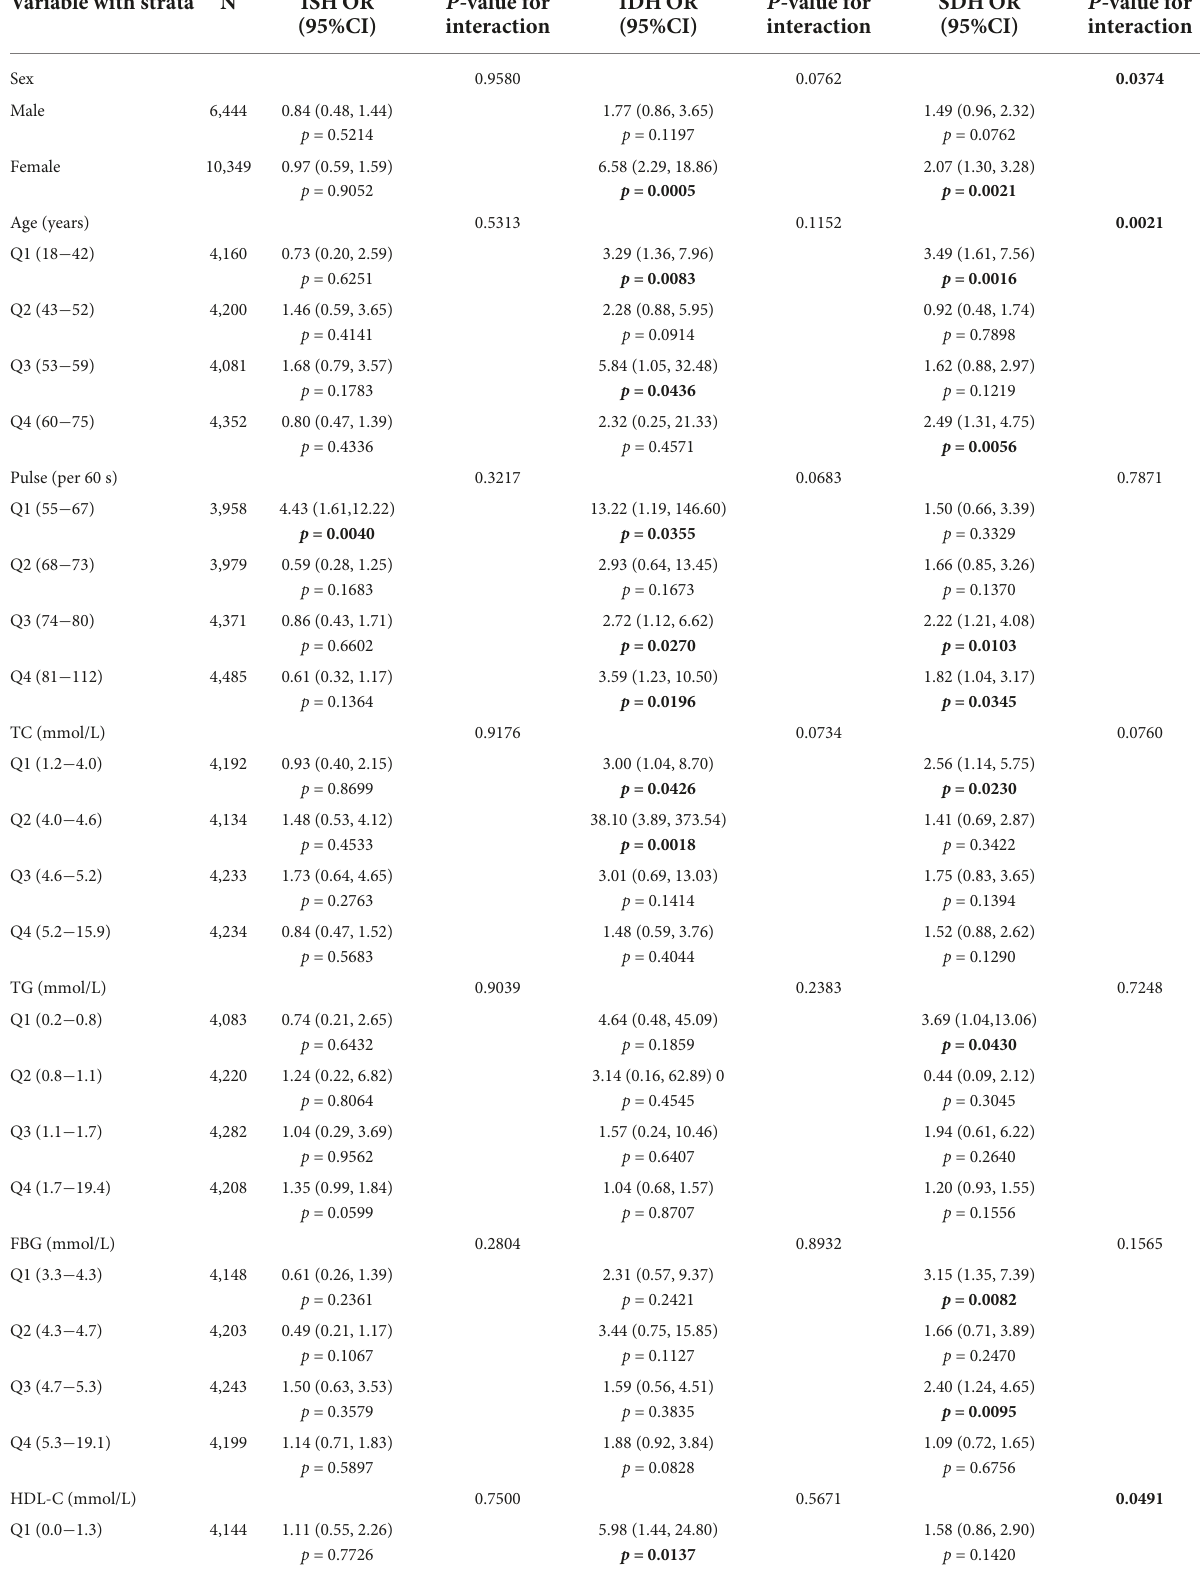
TABLE 4 Stratified analyses of the associations between hypertension subtypes and TyG index with interactions, Shandong, China (2007 − 2010). Variable with